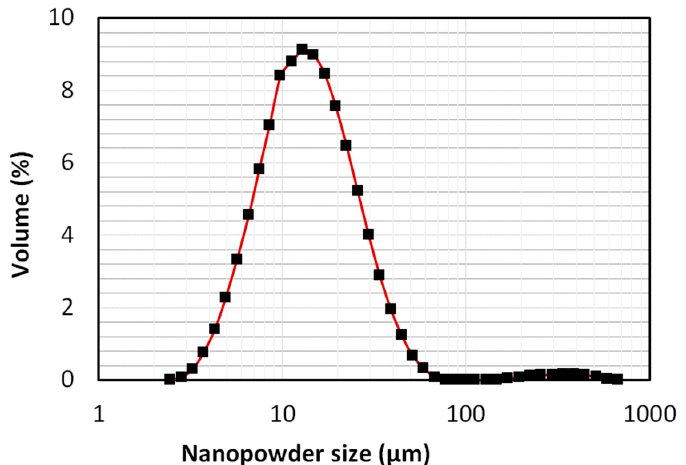
Figure 2. Particle size distribution of the sieved sample of the hydrophilic nanopowder.